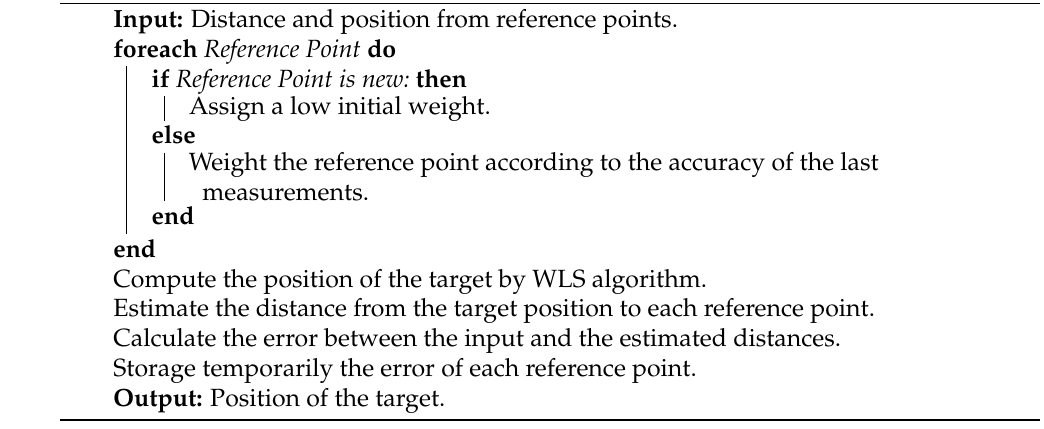
Algorithm 1: Positioning algorithm with MLE and fusing